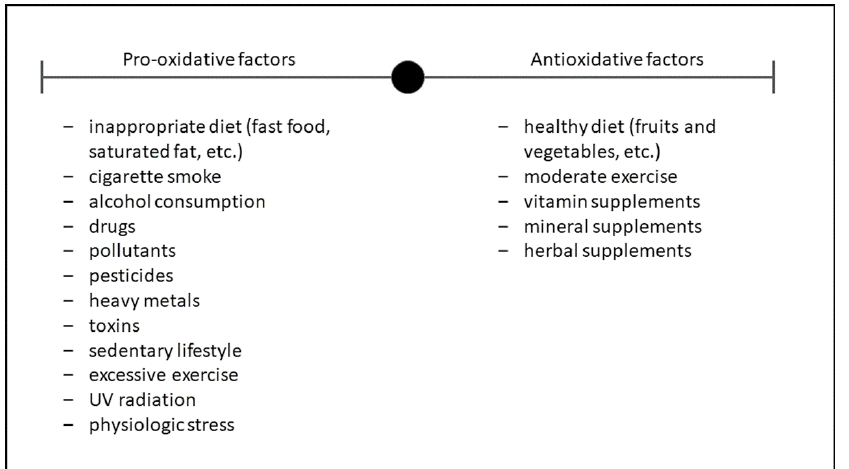
Figure 4. Influence of lifestyle on oxidative stress. On the left side, the factors that favor the oxidative state are listed, while on the right side are those that favor antioxidant activity.